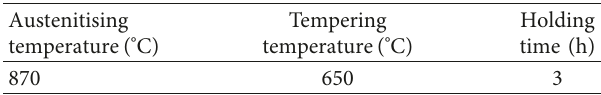
Figure 3: The flow chart of the main shaft heat treatment process. Table 3: Heat treatment